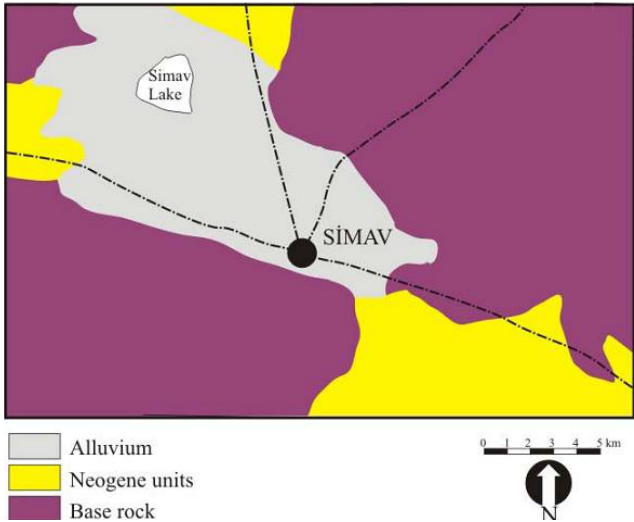
Figure 4. Geological map of Simav and immediate surroundings prepared by MTA [5].